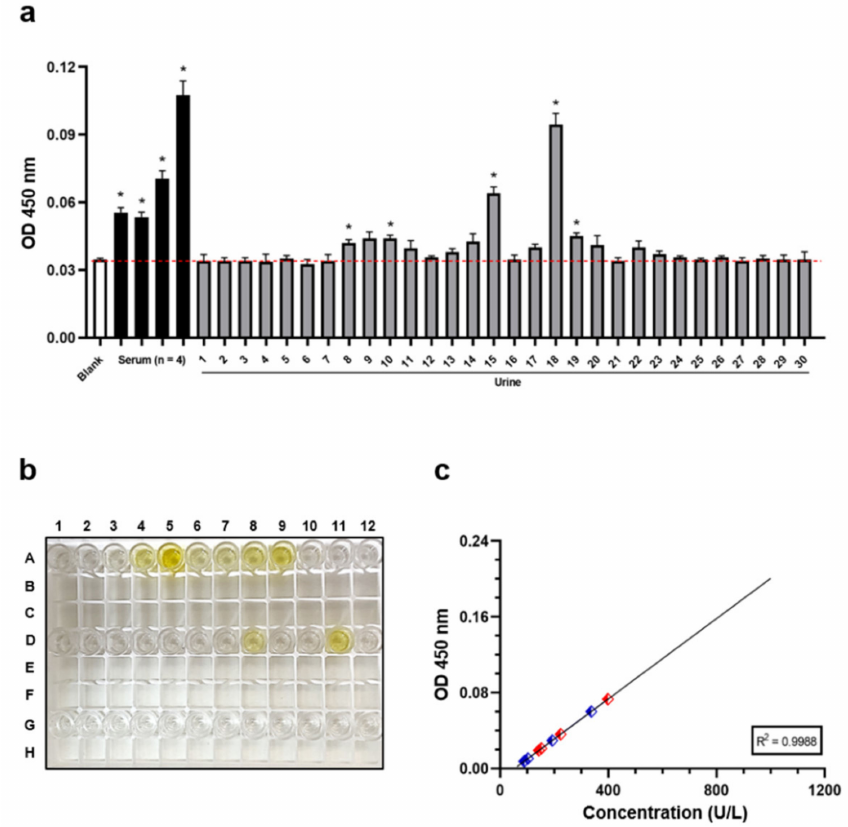
Figure 1. Evaluation of PKA’s presence in human urines. ( a ) Four serum and thirty urine samples were tested with the purpose of estimating PKA’s presence by ELISA assay. O.D. value ± Standard Deviation (SD) of each individual specimen is reported in graph. ( b ) Representative ELISA Strip-Wells. A1 Blank; A2-A5 Standards; A6-A9 Serum; A10-A12, D1-D12, and G1-G12 Urine. ( c ) PKA standard curve and relative levels in positive biological samples. Red dots indicate the PKA concentration in serum, blue dots indicate it in urine instead. * p < 0.05 by Welch’s t